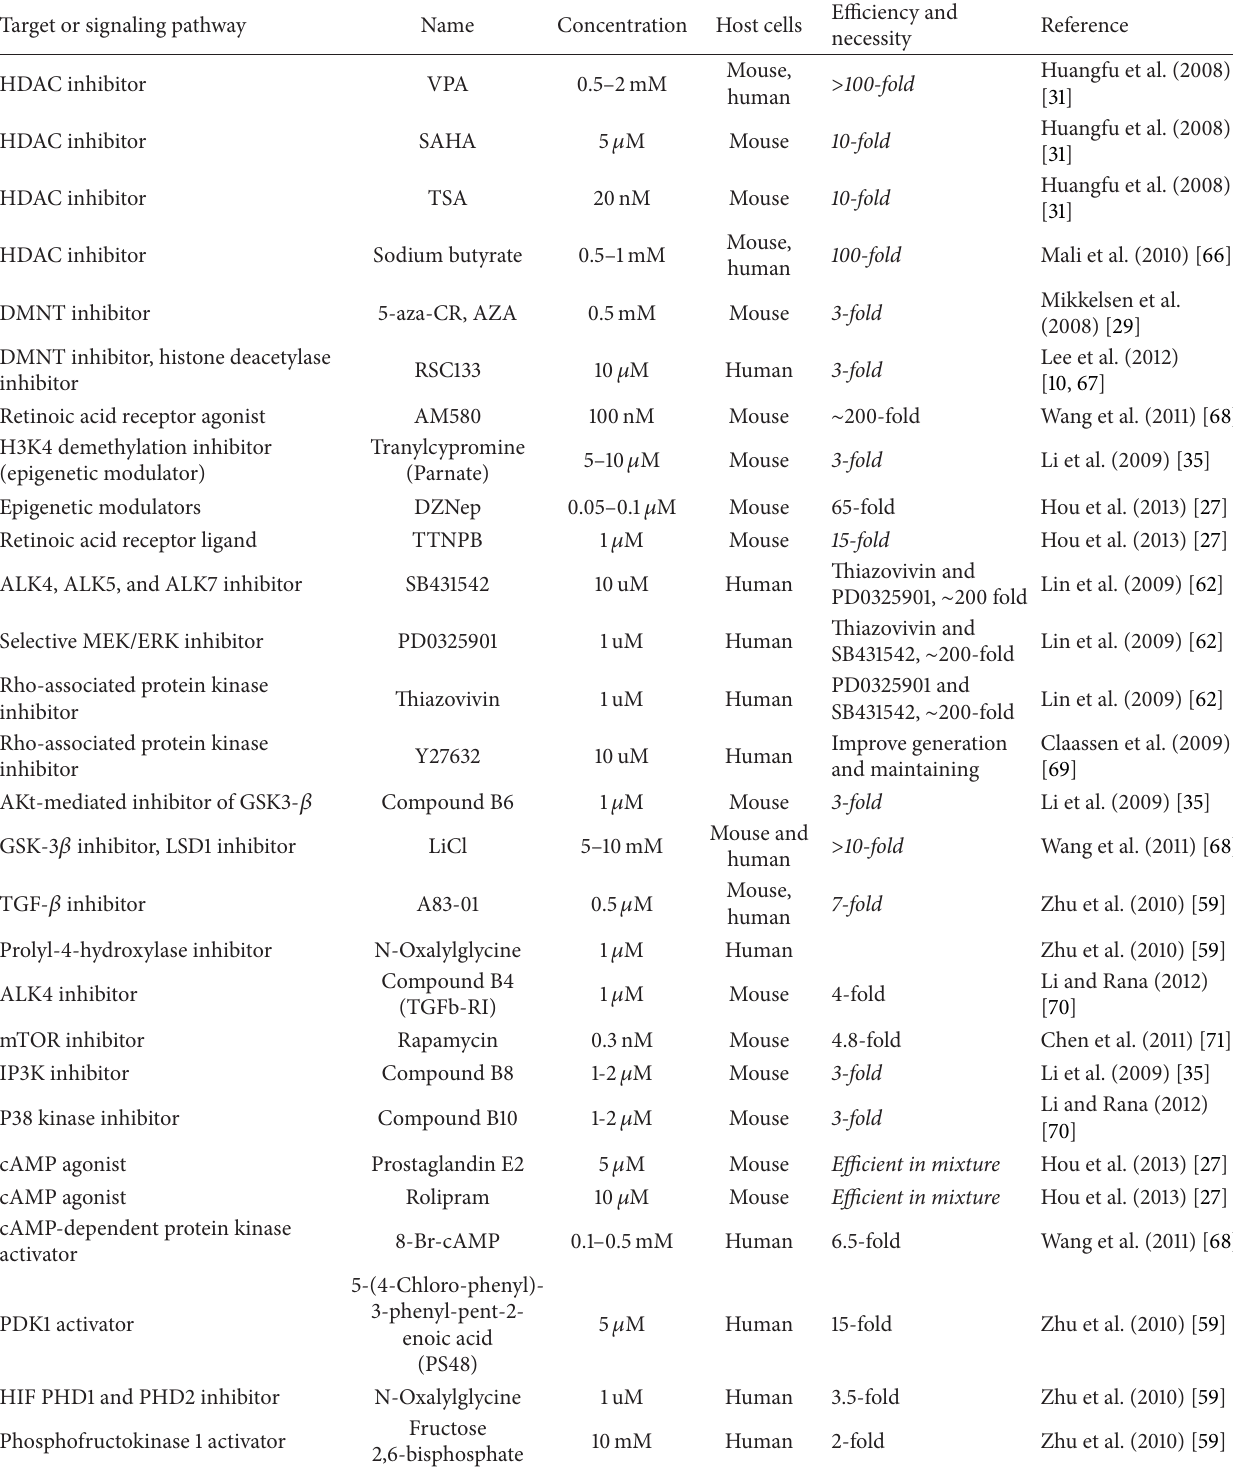
Table 1: Small molecules that enhance iPSC generation efficiency and